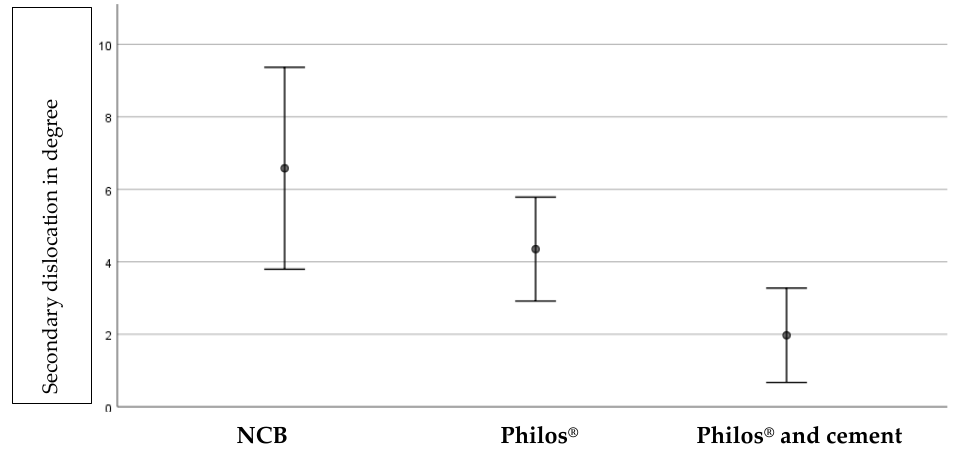
Figure 6. Secondary dislocation in degree ( y axis) divided into the different type of treatments.